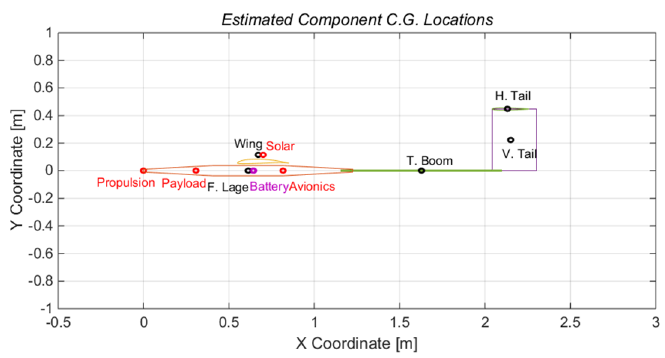
Figure 12. Mass distribution for required C.G. location, Design-3.